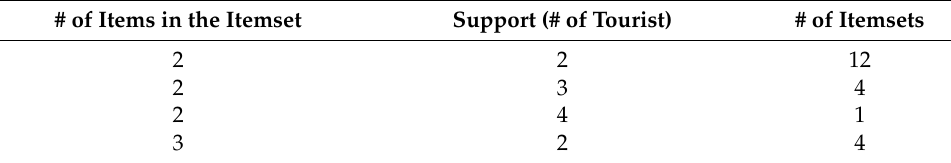
Table 5. Distribution of itemsets for Interpretation 2.